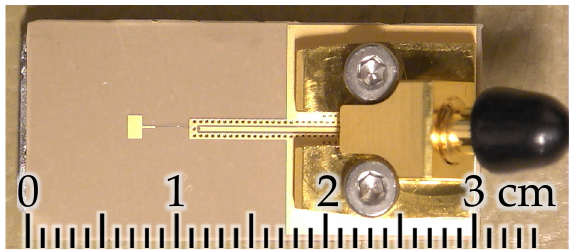
Figure 13. Wire-bonded patch antenna with a solderless PCB to 1.00-mm coaxial adapter (reference scale in centimeters).